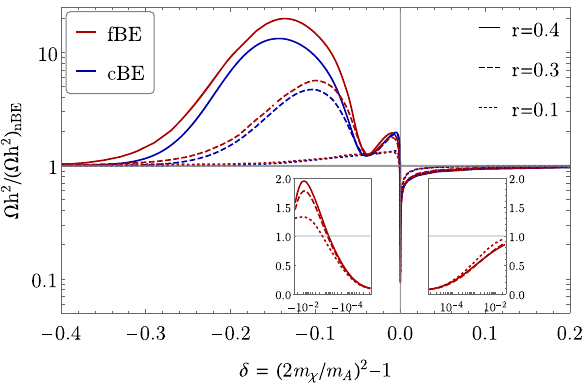
Fig. 2 The relic abundance, for a model with resonant annihilation , in the cBE (blue) and fBE (red) treatments, relative to that of the standard approach ( nBE ), as a function of the distance δ to the resonance. The different line style indicates different mass ratios r = m f / m χ . In this example, m χ = 1TeV, ˜ γ = 10 − 5 and coupling values are fixed by the requirement 2 (Ω χ h 2 ) nBE = Ω DM h 2 . The inset plots show zoom-ins of the resonant region around δ =